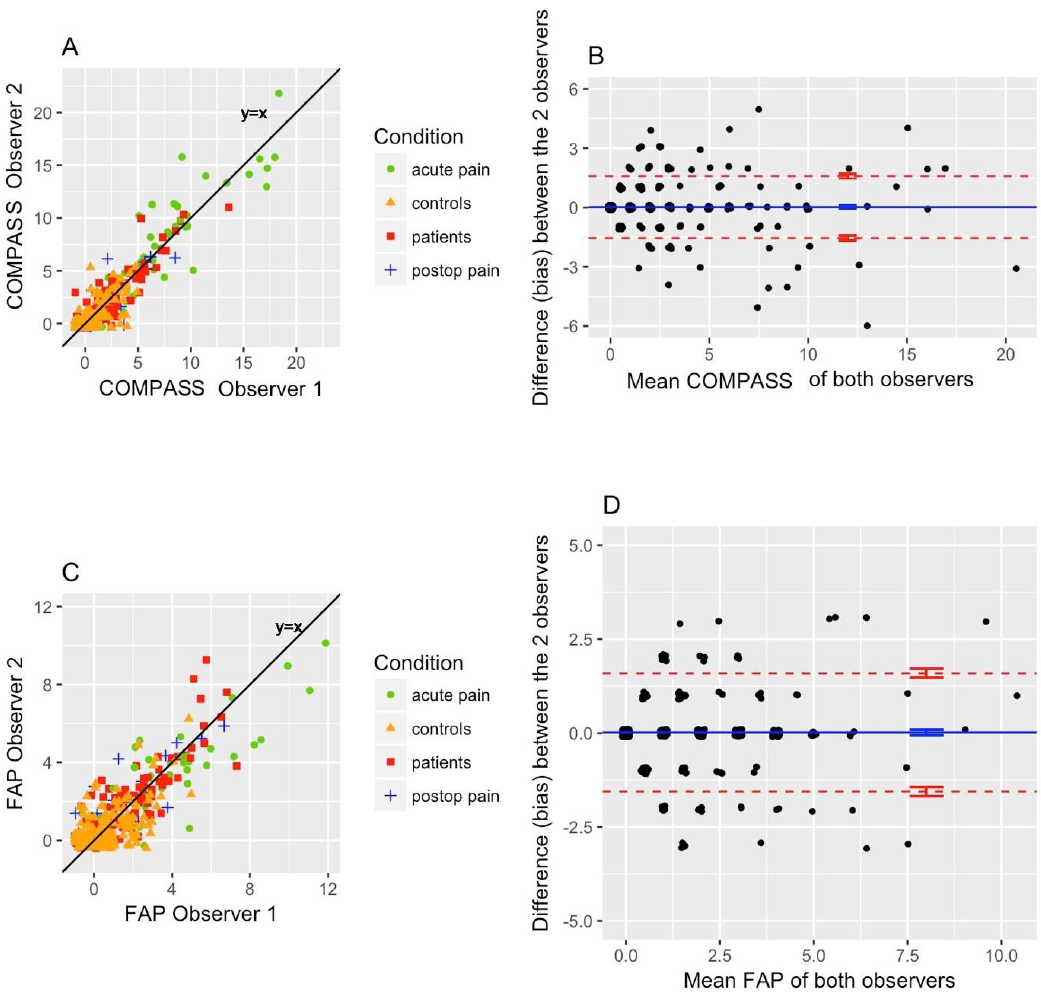
Figure 2. Inter-observer reliability. Equine Utrecht University Scale for Donkey Composite Pain Assessment (EQUUS-DONKEY-COMPASS): Cronbach’s alpha = 0.97 ( p < 0.001), bias = 0.02, and limits of agreement of − 1.9 to +2.0 ( n = 497) ( A , B ). Equine Utrecht University Scale for Donkey Facial Assessment of Pain (EQUUS-DONKEY-FAP): Cronbach’s alpha = 0.94 ( p < 0.001), bias = 0.02, and limits of agreement of − 1.55 to + 1.59 ( n = 497) ( C , D